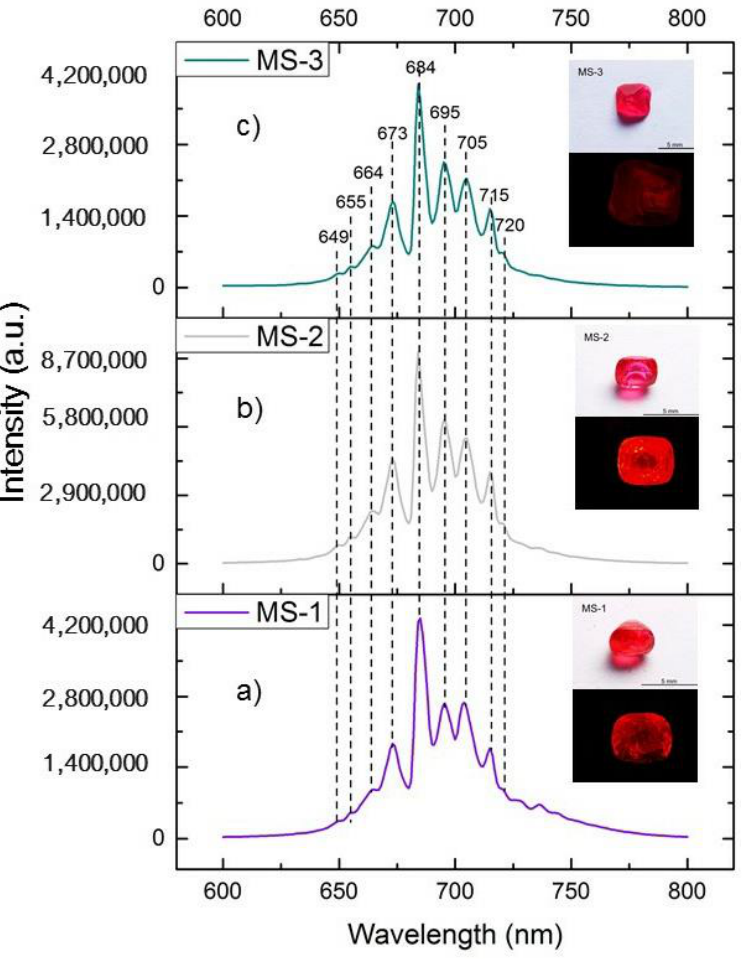
Figure 10. Fluorescence spectroscopy with a photo under DiamondView of ‘Jedi’ spinel from Man Sin. ( a ) MS-1; ( b ) MS-2; ( c ) MS-3. Table 3. EDXRF Cr 2 O 3 and ZnO data of MS-1, MS-2, MS-3